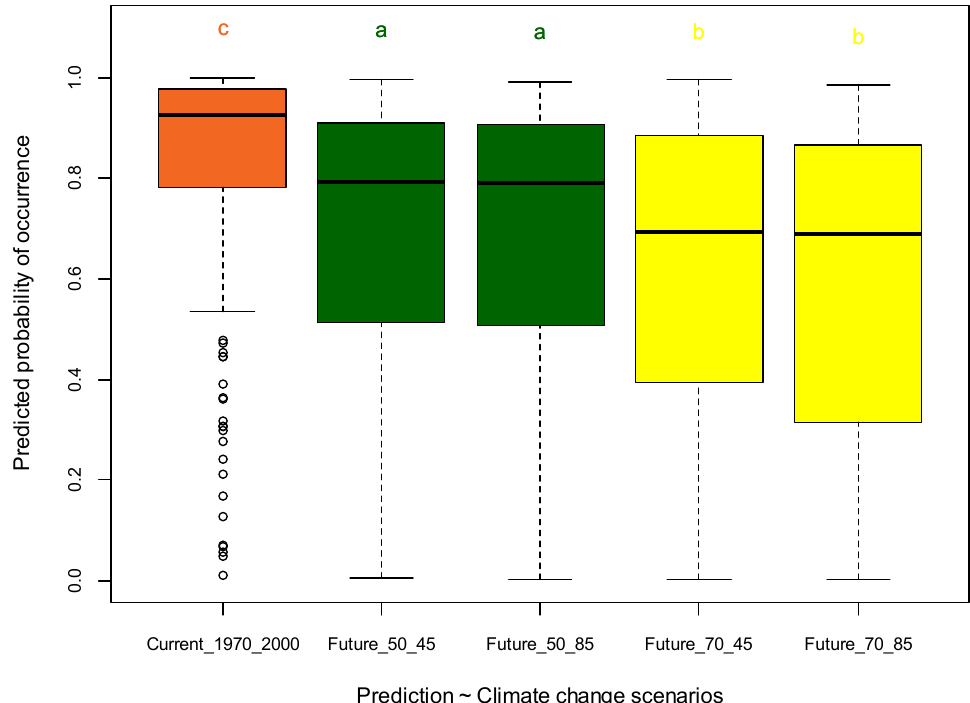
Figure 9. Tukey’s post-hoc test results depicting the significant difference in the predicted probabilities of occurrences of Pinus gerardiana under considered climate change scenarios at the observed species locations.